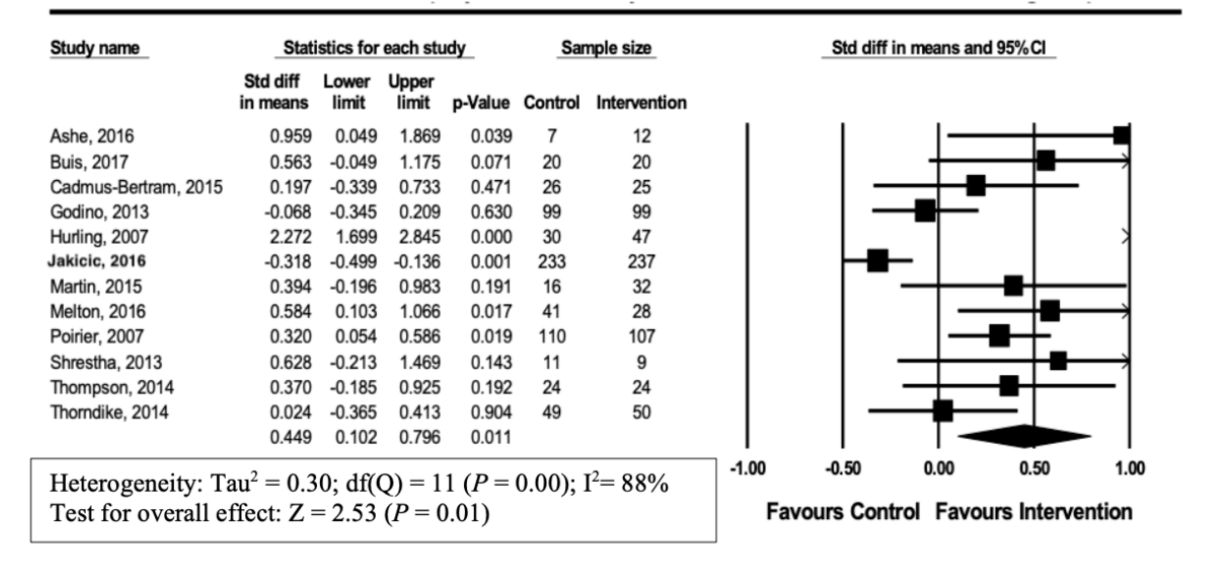
Figure 2. Forest plot of standardized mean difference (95% CI) in the effect of wearable trackers on physical activity.